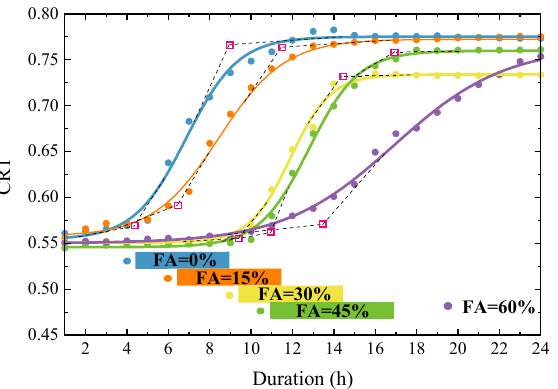
Figure 9. Variation of CR1 as a function of curing duration for SCC specimens with different FA replacement ratios.